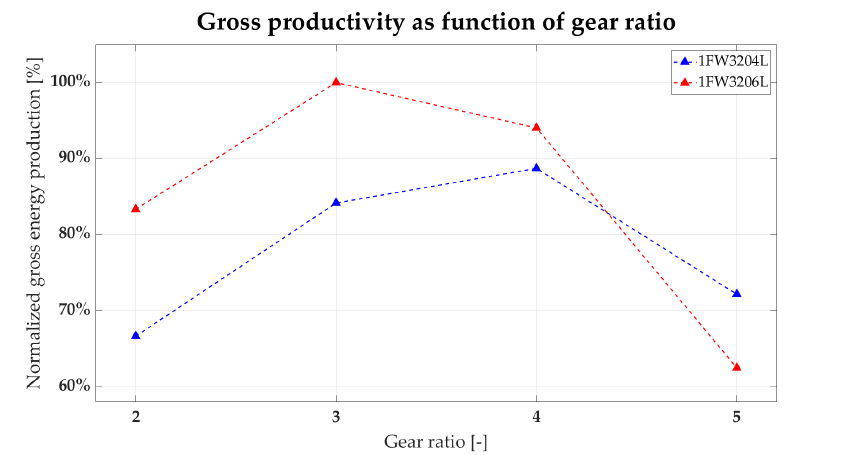
Figure 8. Gross productivity as function of gear ratio. Table 3. Configuration parameters of hull size sensitivity